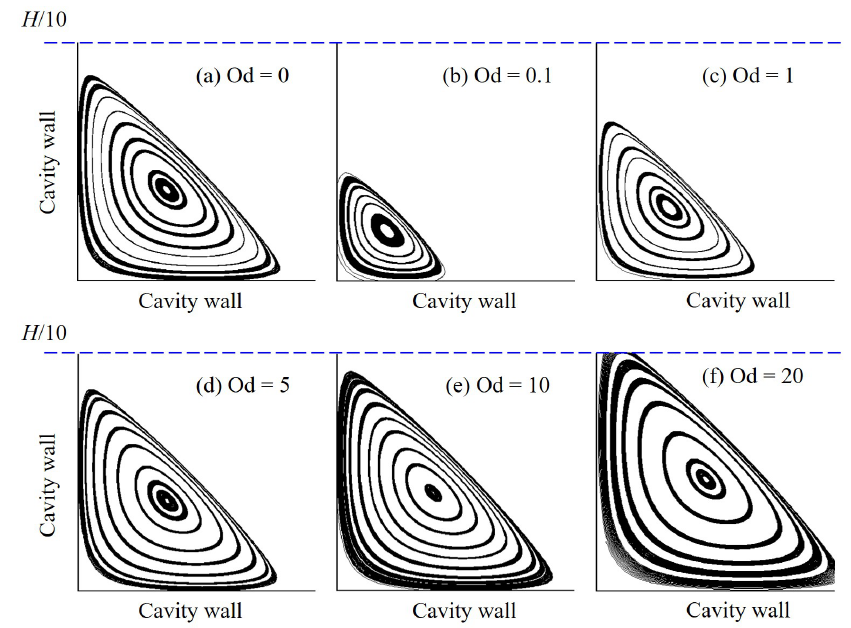
Figure 9. Formation of the left secondary vortex obtained by the polymer flow in a square lid-driven cavity with various values of Od .